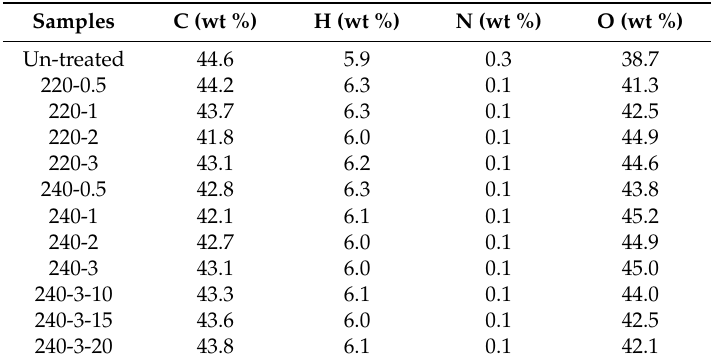
Table 3. Organic elemental analysis of un-treated and glycerol pretreated